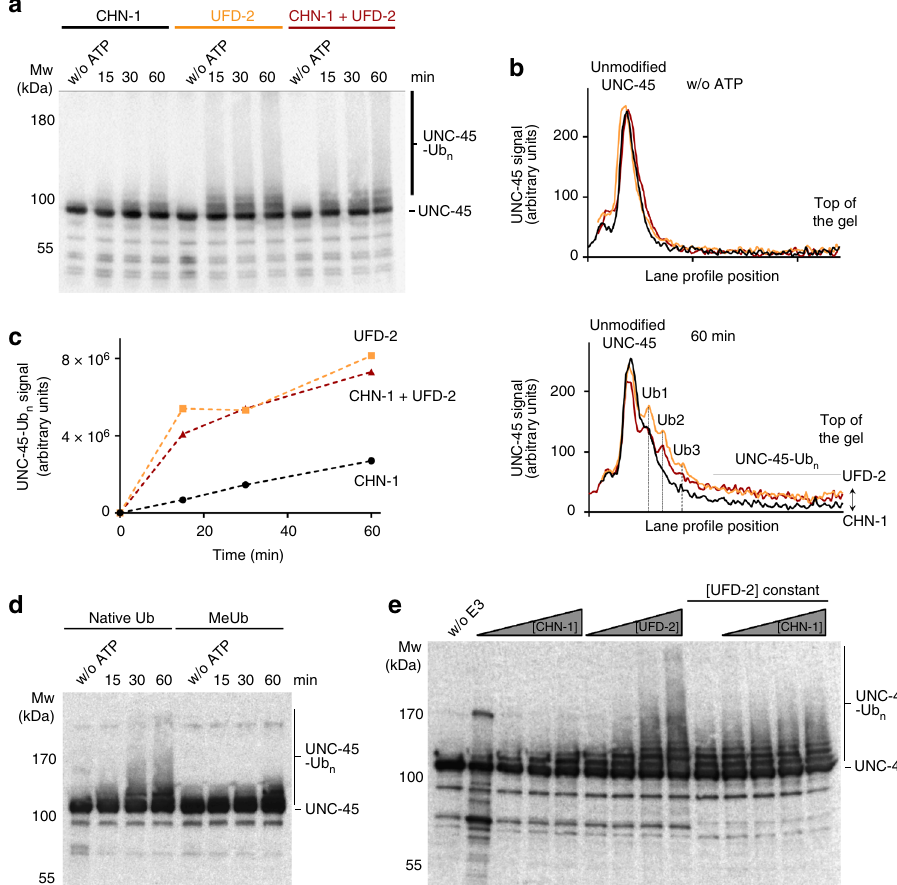
Fig. 1 In vitro ubiquitination of UNC-45 by CHN-1 and UFD-2. a Time-course analysis of UNC-45 ubiquitination by CHN-1, UFD-2, or both E3 ligases. Reactions were incubated for 15, 30, and 60 min with ATP and analyzed by anti-UNC-45 western blot. b Quanti fi cation of the western blot lane pro fi les at time points 0 (without ATP) and 60 min. The two plots show the overlaid pro fi les upon addition of CHN-1 (black), UFD-2 (orange), and CHN-1/UFD-2 (red). c Quanti fi cation of the UNC-45(Ub 2 – Ub n ) signal. The corresponding (Ub 2 – Ub n ) area of the reaction without ATP was used for background subtraction and is displayed as time point 0 for every reaction mix. d Ubiquitination of UNC-45 by UFD-2 using native or methylated ubiquitin (MeUb), with the latter preventing formation of poly-ubiquitin chains. Reactions were incubated for 15, 30, and 60 min with ATP and analyzed by anti-UNC-45 western blot. e Analysis of UNC-45 ubiquitination by using increasing concentrations (0.25, 0.5, 1, and 2 μ M) of UFD-2 or CHN-1. To evaluate the possibility of a composite UFD-2/CHN-1 E4 activity, different amounts of CHN-1 (0.25, 0.5, 1, and 2 μ M) were added to ubiquitination reactions containing 0.5 μ M UFD-2. All assays were incubated for 60 min and were analyzed by anti-UNC-45 western